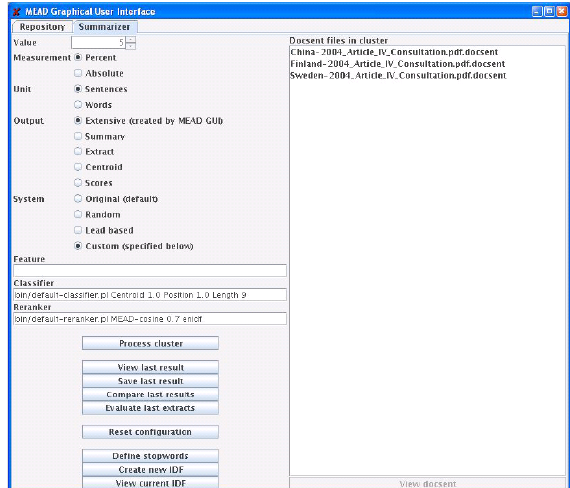
Fig. 2. MEAD-GUI summarizer